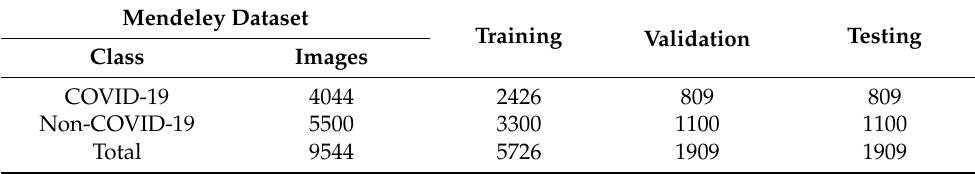
Table 1. Summary of the Mendeley dataset.